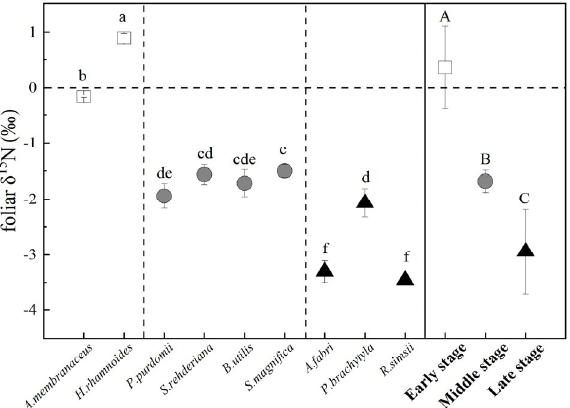
Figure 2. Foliar δ 15 N values of dominant species at different successional stages. White, gray, and black circles represent species from the early- (~12 year), middle- (~40 year), and late-(~120 year) succession stages, respectively. Different capital and lowercase letters denote significant differences among successional stages, and different species, respectively ( p < 0.05), according to Tukey’s test of one-way ANOVA.